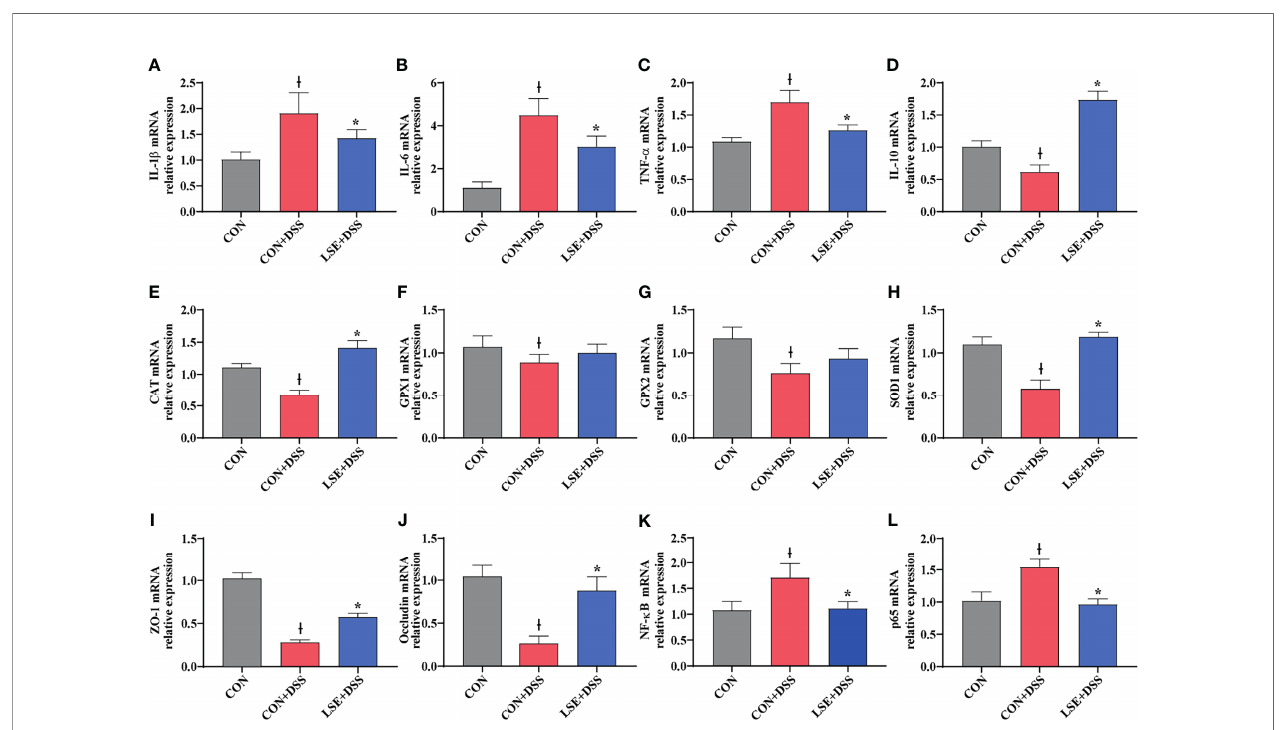
FIGURE 4 | Effects of LSE supplementation on the expression of in fl ammation cytokine, antioxidant parameters, tight junction proteins, and NF- k B target gene mRNAs in the colon in DSS-induced colitis mice. (A) IL-1 b . (B) IL-6. (C) TNF- a . (D) IL-10. (E) CAT. (F) GPX1. (G) GPX2. (H) SOD1. (I) ZO-1. (J) Occludin. (K) NF- k B. (L) p65. Data are presented as mean ± SEM, n = 8. * P < 0.05 vs. the CON+DSS group, † P < 0.05 vs. the CON